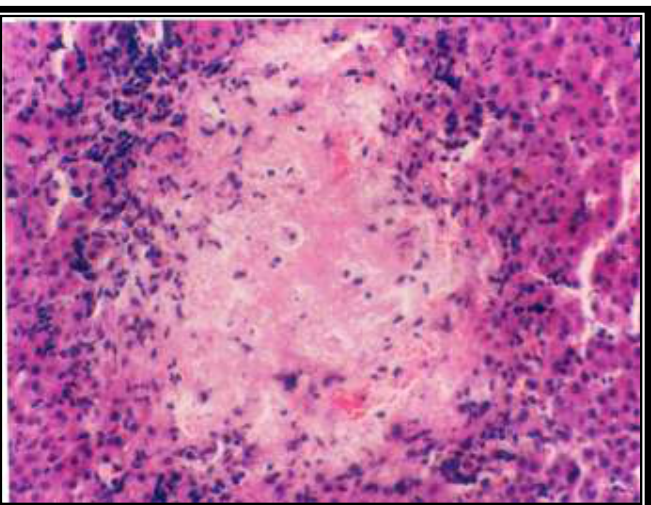
Figure (6) Liver section shows tubercle with cellular infiltration and congestion